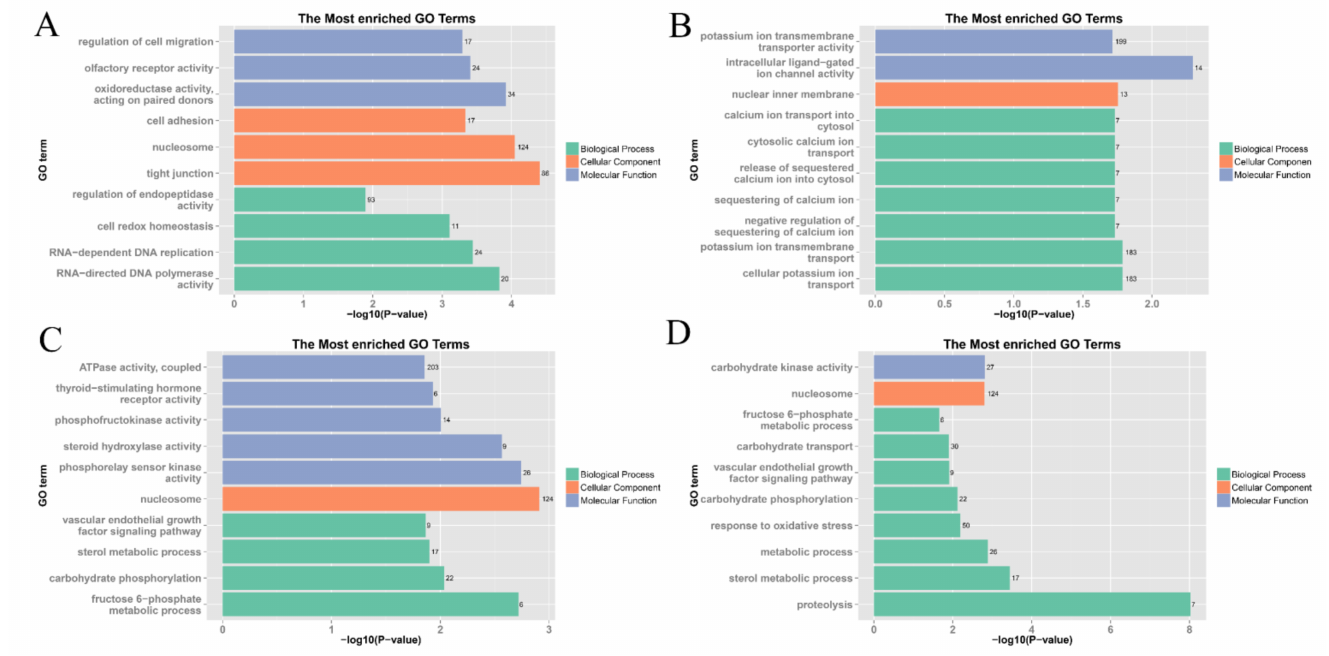
Figure 4. Gene ontology (GO) enrichment analysis of genes within highly correlated modules. ( A ) darkorange module; ( B ) magenta module; ( C ) saddlebrown module; ( D ) darkolivegreen